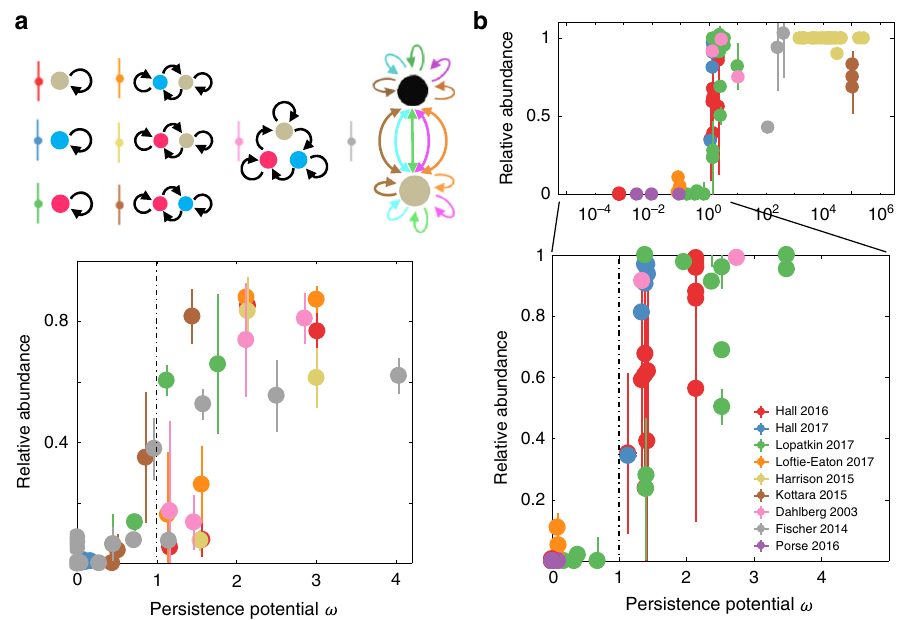
Fig. 4 Experimental validation of the predictive power of ω . a Experimental test with eight synthetic communities. The fi rst seven communities (upper panel) transferring a single plasmid were constructed using three engineered E. coli strains. Strain B (blue) expresses BFP chromosomally; strain R (red) expresses dTomato; and strain X (gray) does not express a fl uorescent marker. We assembled three single-population communities, two pairwise communities, and one three-population community. Black arrows indicate the plasmid transfer. Dilutions of four different ratios (10 3 , 10 4 , 10 5 , 10 6 ) were performed every 24 h to maintain the growth. The relative abundances and persistence potentials of the plasmid in the seven communities at the end of the experiments (day 15) are shown in the lower panel. The error bars represent the standard deviations of three replicates. The eighth community transferring multiple plasmids was composed of two E. coli strains, MG1655 and DH5 α . Five self-mobilizable plasmids, F ’ (lncF, Tet R ), PCU1 (lncN, Amp R ), R388 (lncW, Tm R ), R6K (lncX, Strp R ), and RP4 (lncP, Kan R ), were transferring within the community. The composition of the community was determined by blue-white screening on X-gal plates. The relative abundance of each plasmid was determined by selective plating with the corresponding antibiotics. Four different ratios (10 3 , 10 4 , 10 5 , 10 6 ) were performed every 24 h. The relative abundances and persistence potentials of the fi ve plasmids at the end of the experiments (day 15) are shown in the lower panel. Data are presented as mean values + / − the standard deviations of three biologically independent replicates. b Evaluation of literature data. Data were extracted and reanalyzed from 9 previous studies (Supplementary Tables 3 – 16). Data are presented as mean values + / − the standard deviations of multiple biologically independent replicates. The number of replicates ranges from three to six, depending on the rationale of each study. The distribution is shown in the logarithmic scale (upper panel) or linear scale of ω (lower